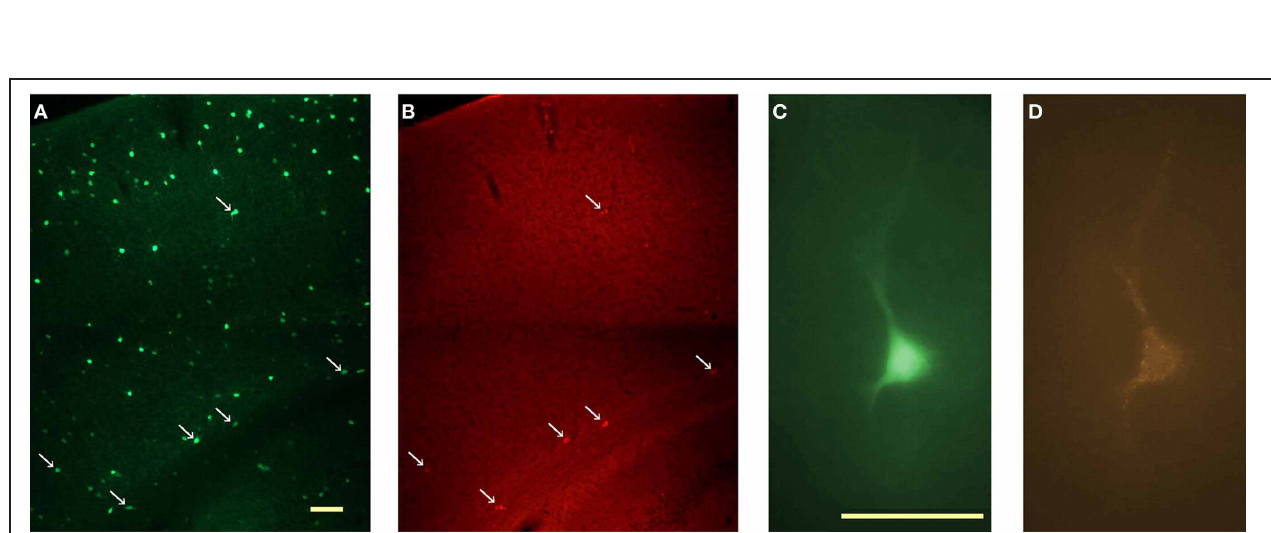
FIGURE 2 | Colocalization of NK1 and nNOS. In mice (A,A’) , virtually all neurons were double-labeled (arrows) for NK1 (green, top panels) and nNOS (red, bottom panels). In rats (B,B’) , we found both double-labeled neurons and neurons labeled for NK1 only (arrowheads). Neurons staining for NK1 alone had smaller somata and less intense labeling. Portions of the micrographs containing the weakly labeled NK1 neurons are displayed in the insets (yellow squares) with enhanced brightness to enable visibility. Note the absence of nNOS labeling in these neurons in B’ . In monkeys (C,C’) , double-labeled neurons had a dendritic arborization pattern similar to that of